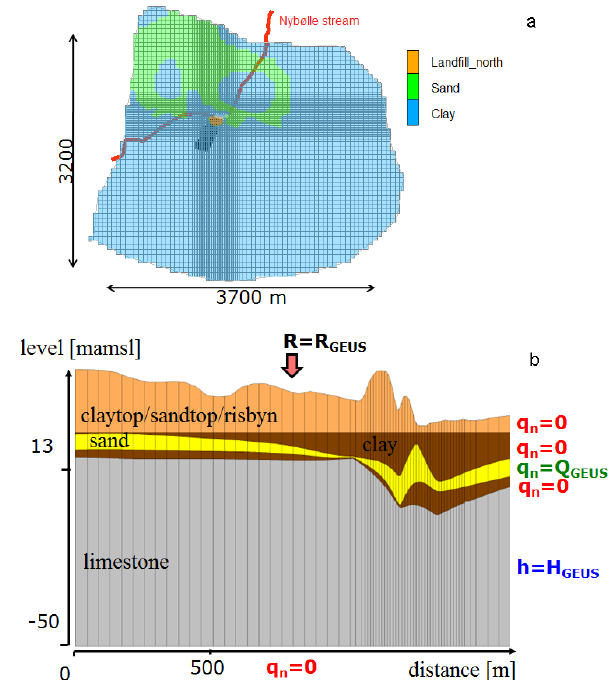
Fig. 7. Horizontal discretization of the Risby groundwater model Fig. 7 Horizontal discretization of the Risby groundwater model and zonation of layer 1 (a) and the geological setup and boundary 3 and zonation of layer 1 (a) and the geological setup and boundary conditions used (b). 4 conditions used (b)